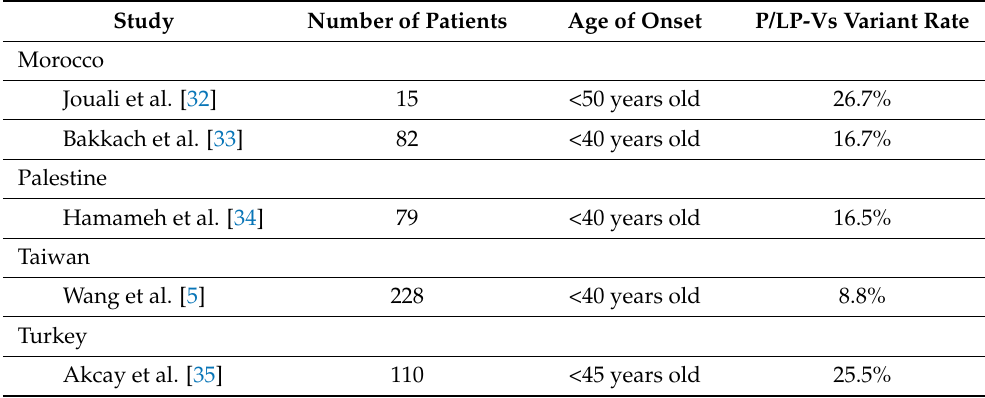
Table 4. Previous studies analyzing BRCA variants using NGS in young breast cancer patients. Study Number of Patients Age of